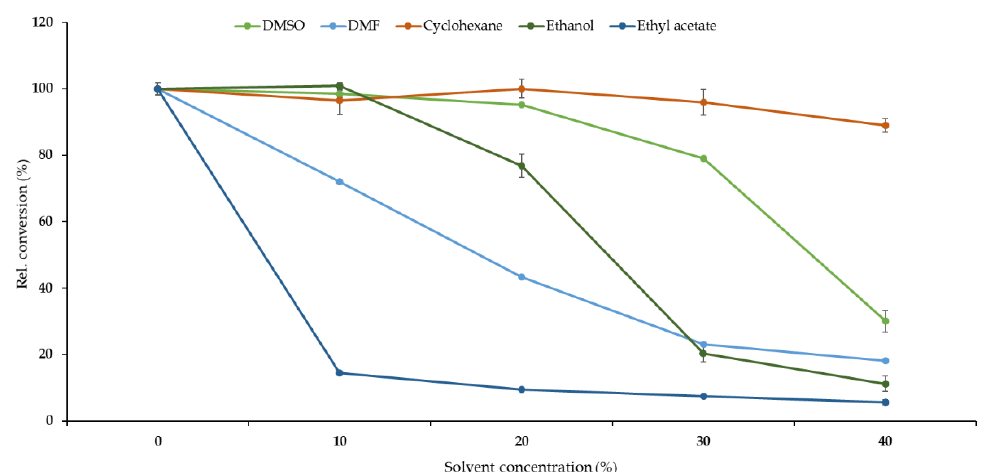
Figure 4. Overview of the solvent stability of Ppo-Er1 in DMSO (dimethyl sulfoxide), DMF (dimethyl formamide), cyclohexane, ethanol, and ethyl acetate in a concentration range of 10%–40% v / v . The standard enzyme assay was performed while the concentration of solvents was varied (substrate for cyclohexane: 1 mM hexenal, all other solvents: 1 mM cyclohexenone). Data are shown as values relative to an enzyme assay without cosolvent in which 100% relative conversion corresponds to the production of 0.84 mM cyclohexanone or 0.49 mM hexanal, respectively. The error bars show the standard deviation of triplicates, except for the 30% v / v cyclohexane point for which only two measurements were available.